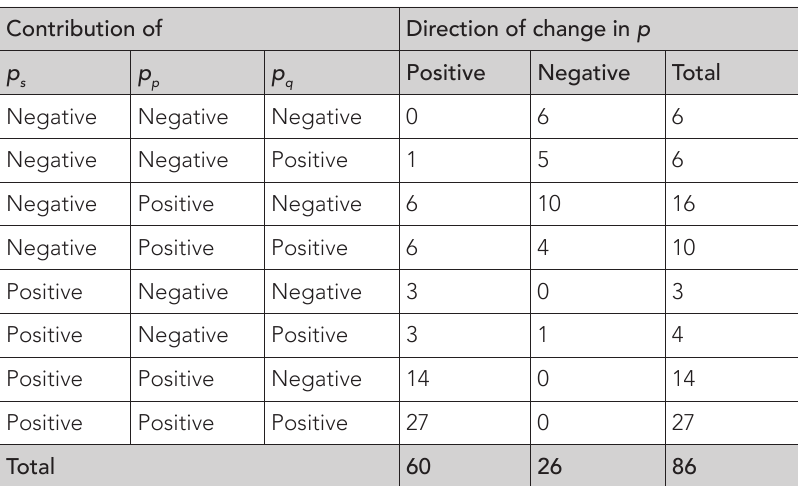
Table 4: Direction of Change in Indexes p s , p p and p q and the Direction of Change in the Index p Contribution